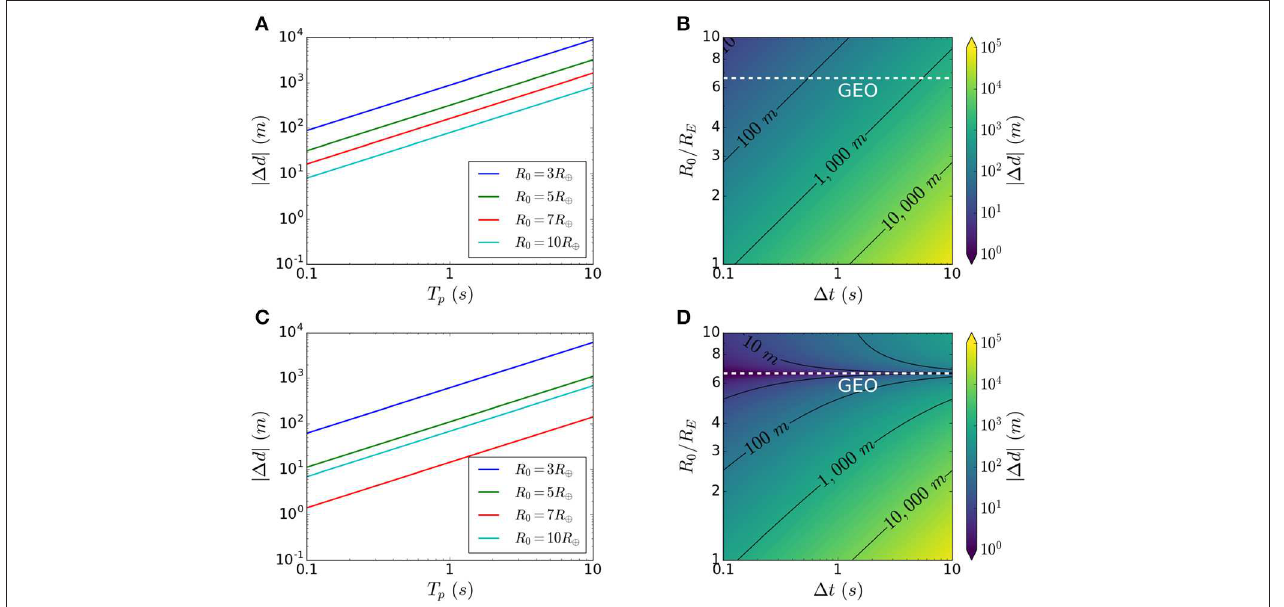
1 d due to motion of a satellite-borne particle accelerator (A,B) satellite motion only, (C,D) satellite motion | |